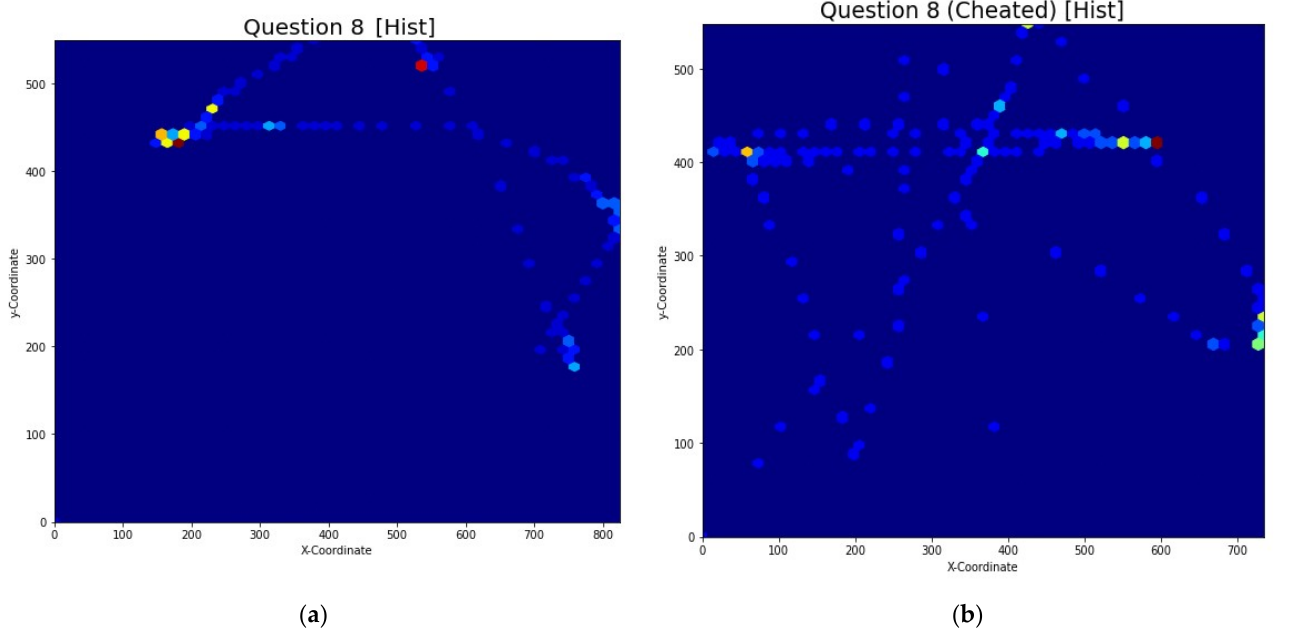
Figure 12. A histogram of raw mouse movements showing the difference in the frequency of movements is as follows: ( a ) a KDE plot of question 8 answered by students without cheating; ( b ) a KDE plot of question 8 answered by students who are allowed to cheat.